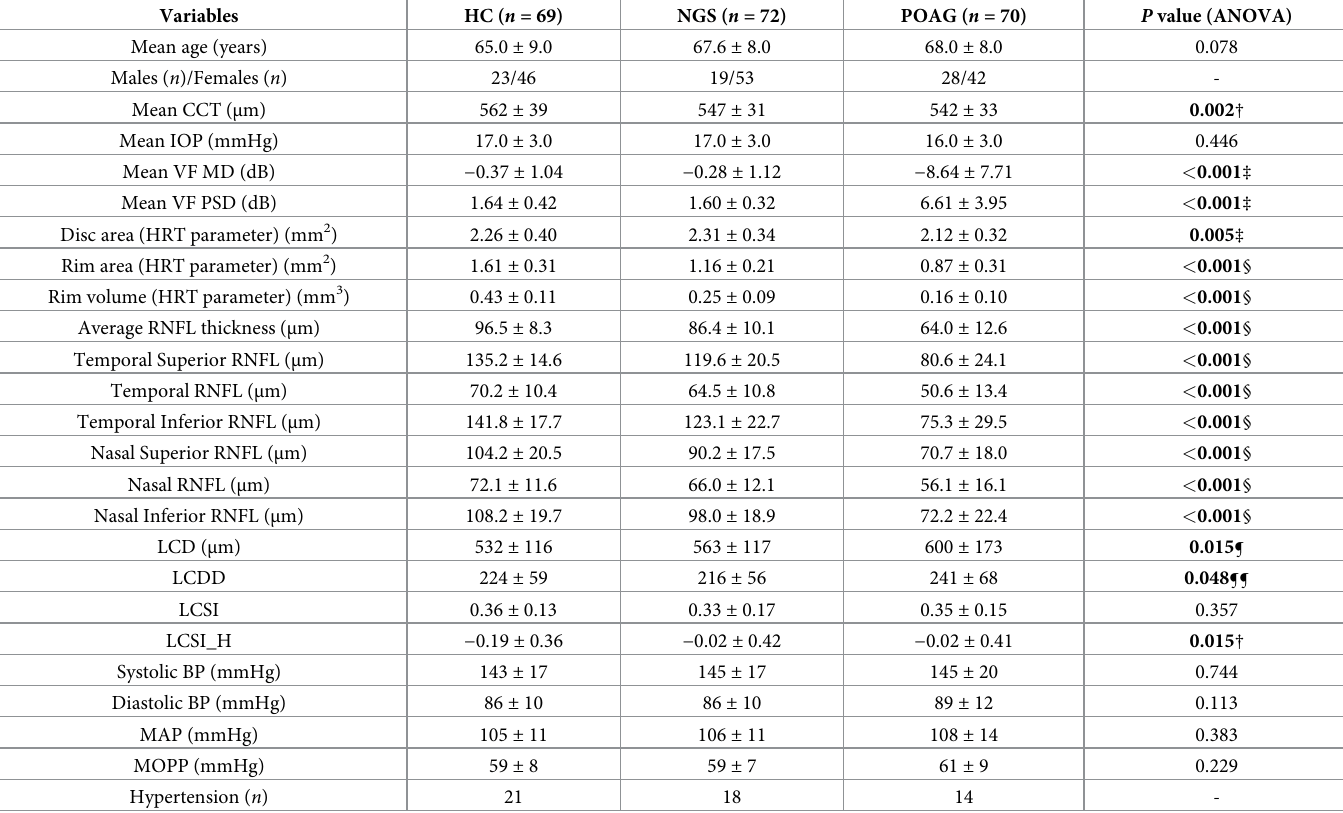
Table 1. Group mean ( ± one standard deviation, SD) results for the considered parameters and the results of ANOVA test ( P value).